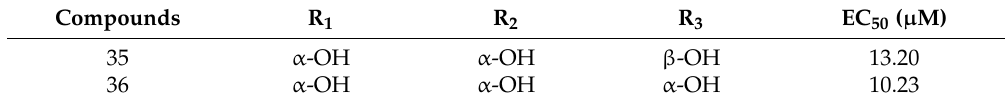
Figure 5. 2D image of the changes to bile acids sca ff old reported in Table 4. Table 4. Modifications made on bile acids sca ff